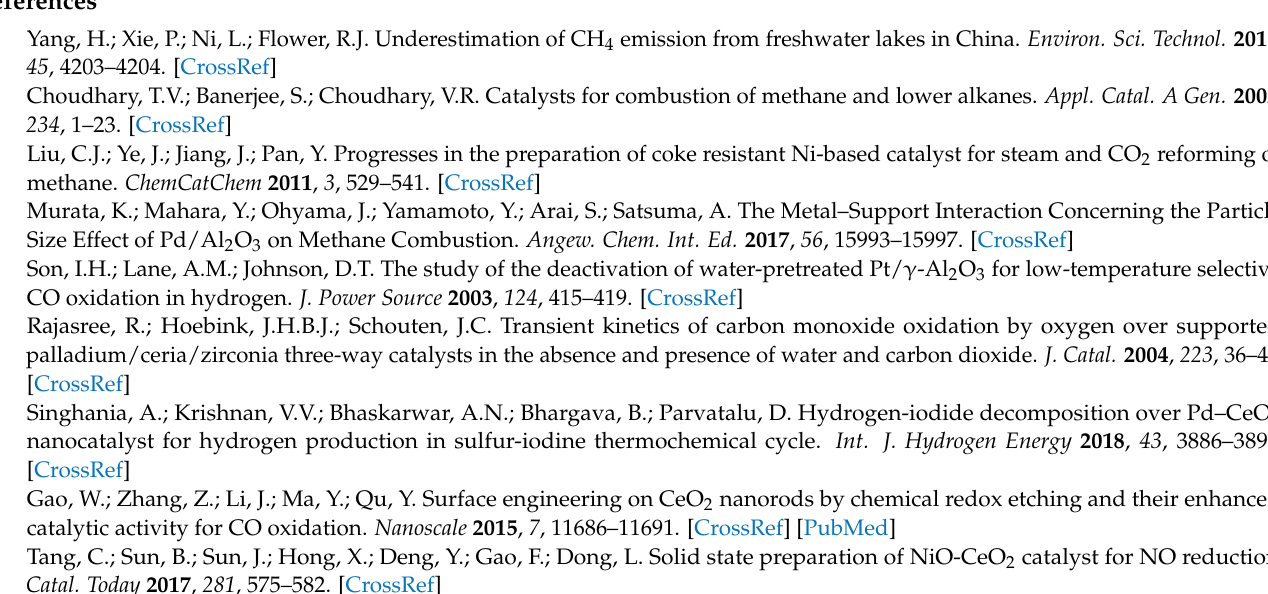
catalysts, Table S1: H 2 consumption of CeO 2 -R and Pd/CeO 2